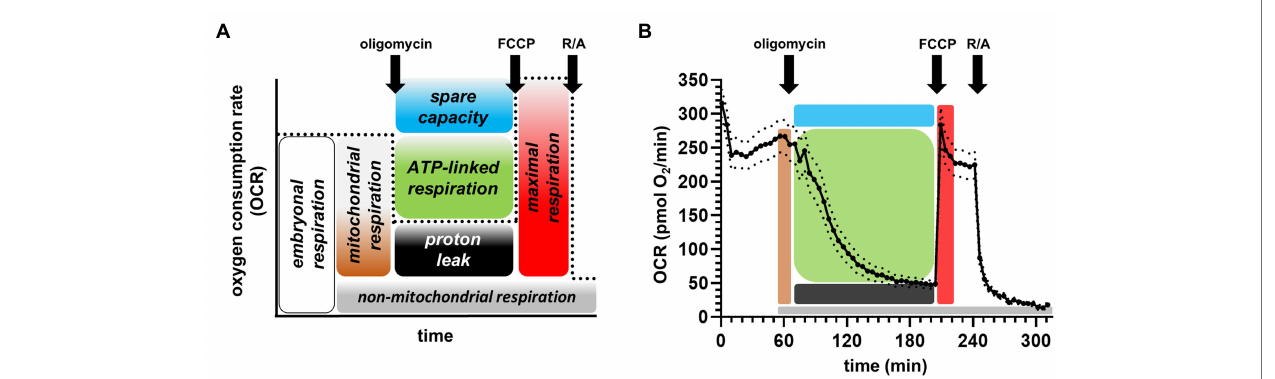
FIGURE 1 | Partitioning embryonic respiration into bioenergetic modules. (A) General scheme depicting the analysis of the mitochondrial stress assay, showing the different respiratory modules. FCCP: carbonyl cyanide-p-trifluoromethoxyphenylhydrazone; R/A: rotenone and antimycin A. (B) Exemplary averaged trace measuring embryos at 28 ° C. The solid trace represents the mean, while the dotted lines depict the standard error of the